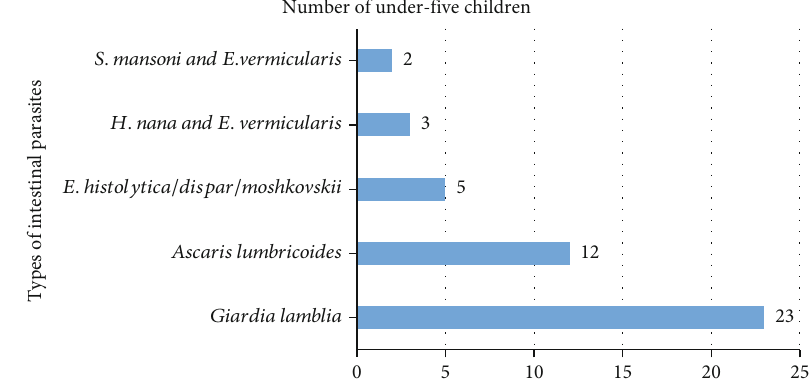
Figure 1: Types of intestinal parasites among under- fi ve children attending at Debre Tabor comprehensive specialized hospital, Northwest Ethiopia, 2021 ( n = 258